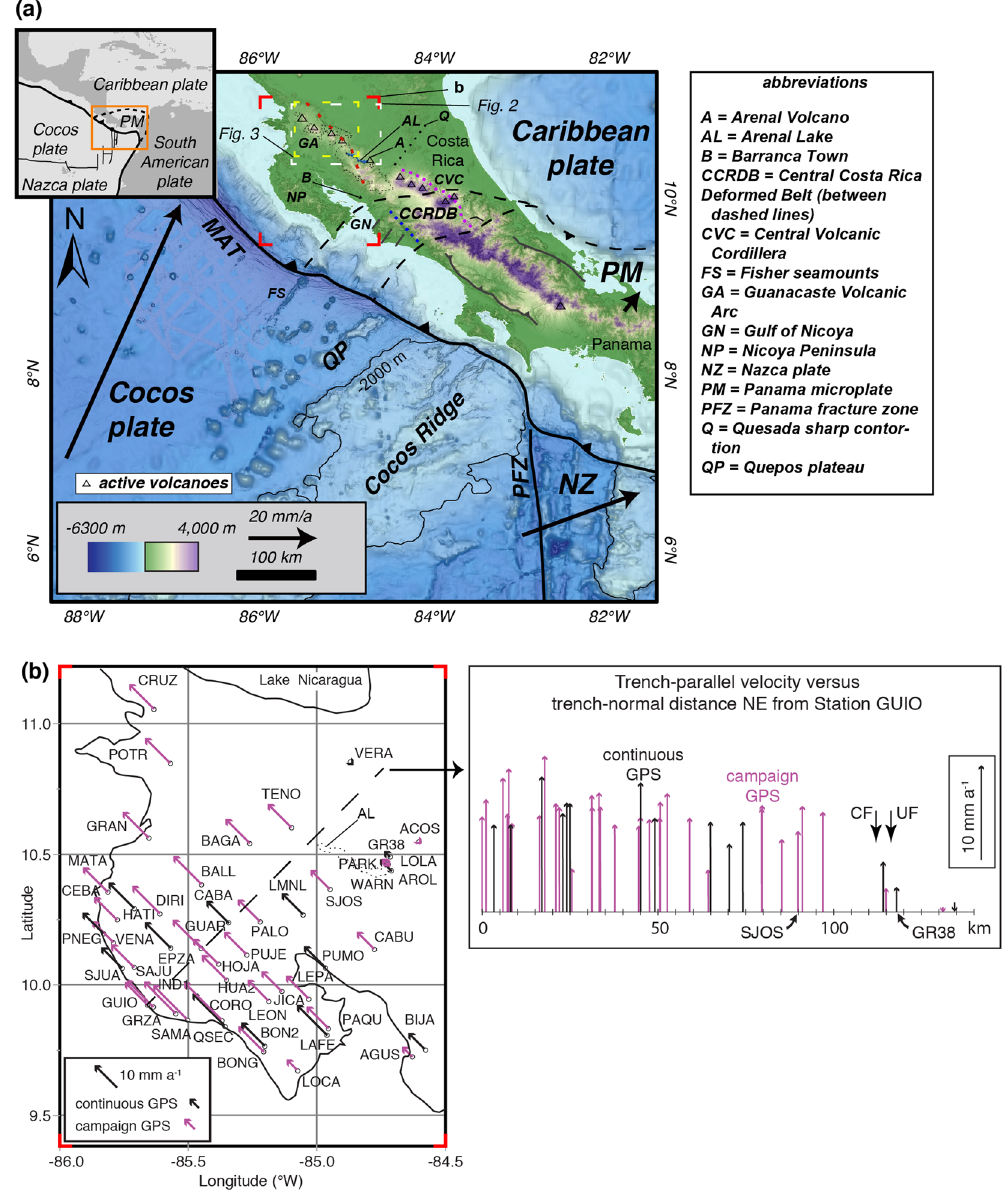
Figure 1. ( a ) Tectonic setting of Costa Rica. Topographic and bathymetric base map simplified from Morell 31 . Dotted outlines are Monteverde arc of Carr et al . 18 . Location of the Quesada Sharp Contortion from Protti et al . 29 . Red dashed line outlines the Haciendas-Chiripa fault system. The dashed magenta and blue lines show the positions of the San Miguel-Atirro-Rio Sucio dextral fault system 6 and the Candelaria fault 6 , respectively. ( b ) Trench-parallel component of GPS velocities from Feng et al . 8 . Magenta vectors are from campaign GPS and black vectors are for permanent GPS stations. The profile at the upper right of ( b ) shows the same velocity plotted versus distance perpendicular to the trench. UF = Upala Fault and CF = Chiquero Fault. The location of Fig. 1b is indicated by red corners. The location of Figs 2 and 3 are shown by the dashed white and yellow boxes, respectively. Map at ( a ) and inset were provided with permission to modify by K. Morell and modified using Adobe Illustrator CC 2015 release. Map and plot at ( b ) were generated using Adobe Illustrator CC 2015